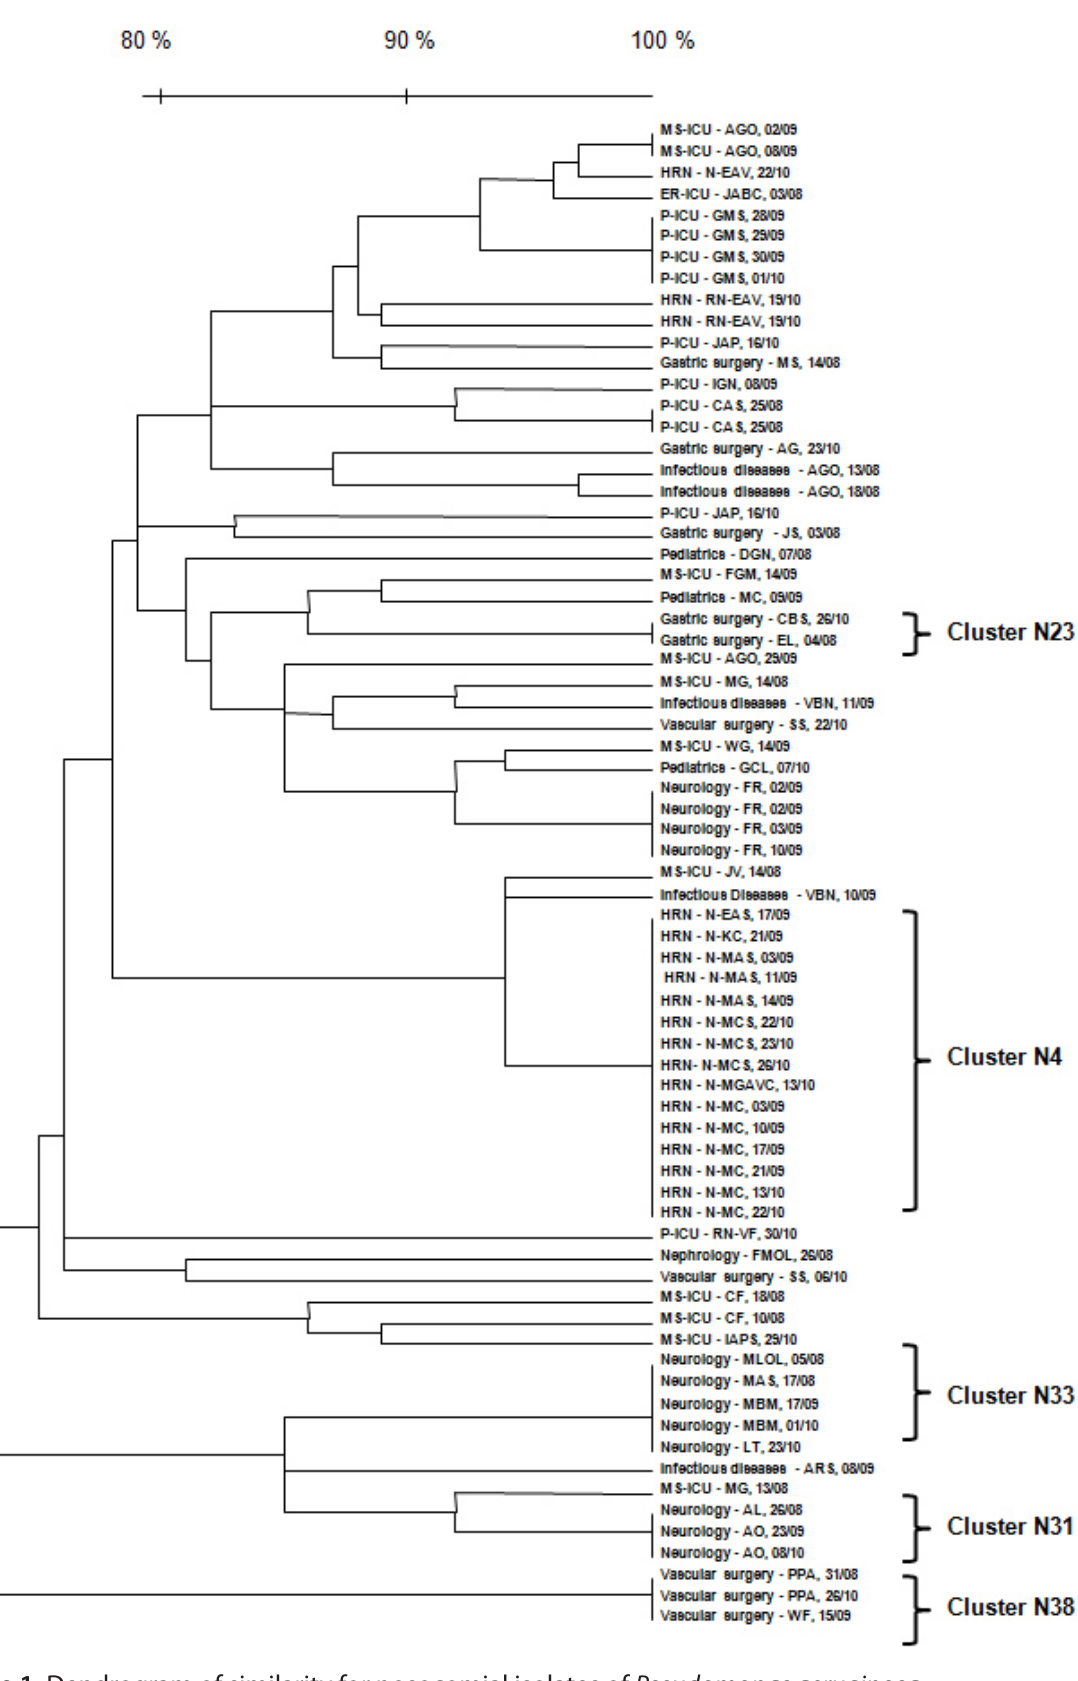
Figure 1. Dendrogram of similarity for nosocomial isolates of Pseudomonas aeruginosa . Note: labels present hospital units, followed by patients’ initials and date of strain isolation in clinical culture (European form, DD/ MM). “N” identifies newborns, followed by mother´s